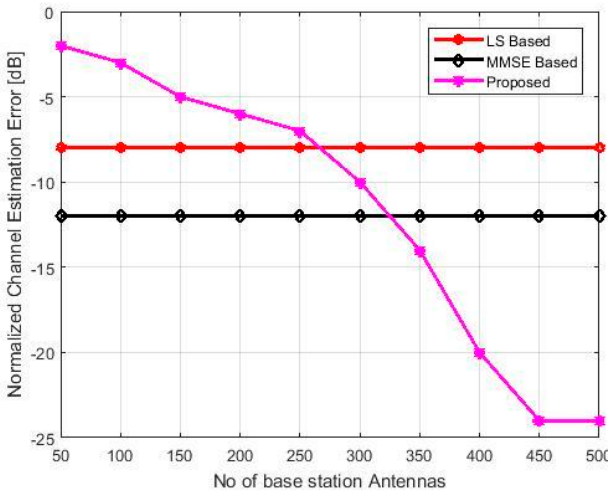
Figure 7. Normalized CE Error vs. number of base station (BS) antennae.